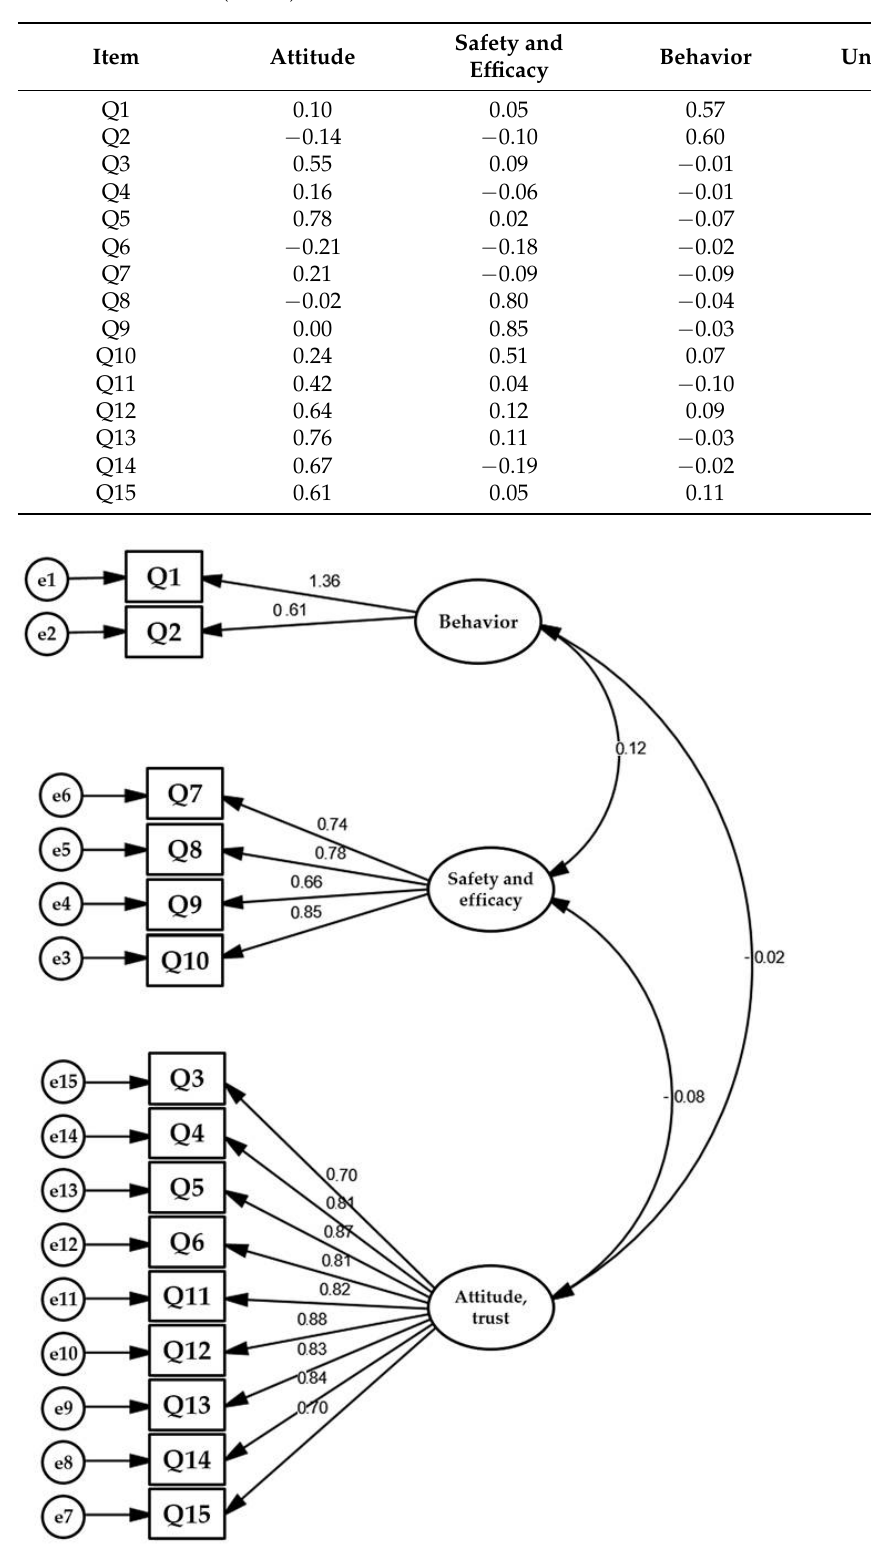
Table 6. Factor loadings, subscales, and labeling of the Arabic version of the Parent Attitudes About Childhood Vaccines (PACV) scale.